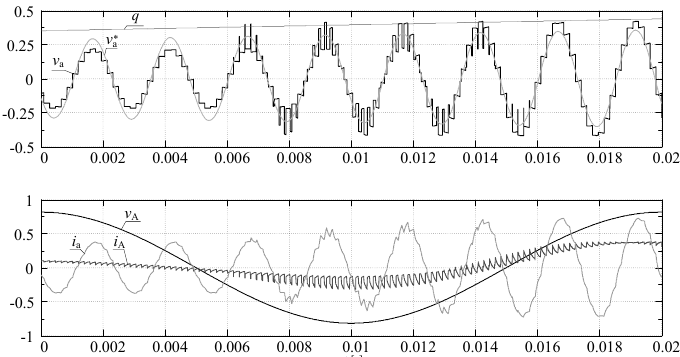
Figure 19. Example output voltage waveforms, for NVM modulation, during gradually increasing the voltage gain q from 0.27 to 0.43 for k f = 8.